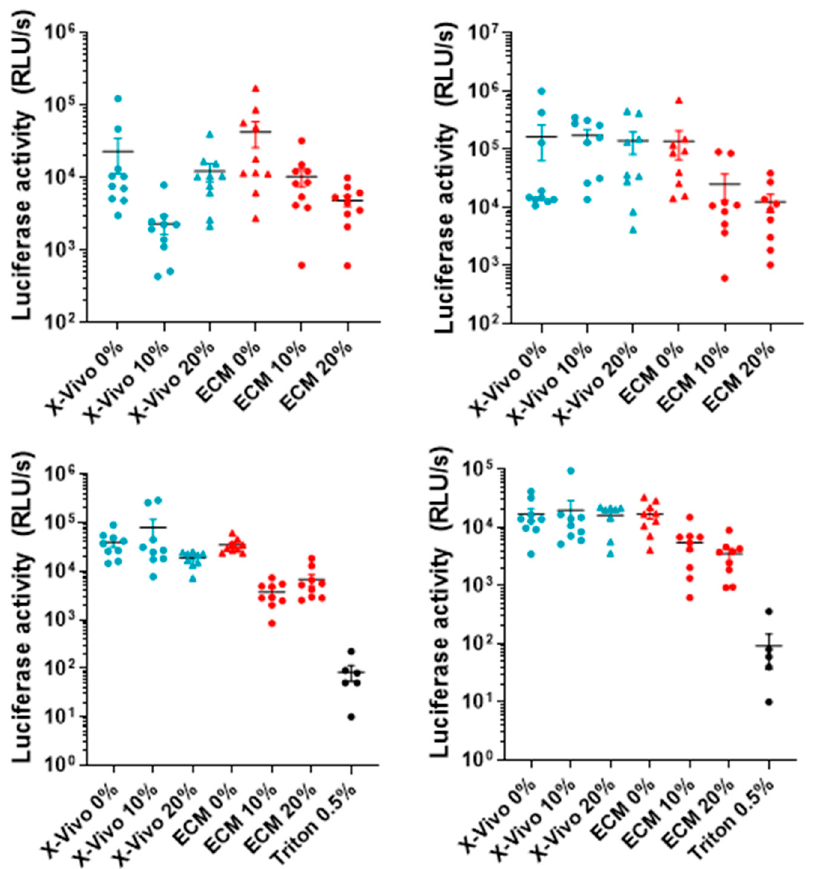
Figure A3. The AG in a serum-free medium strongly reduces seminal plasma-derived cytotoxic effects in primary vaginal tissue. Here, 2 × 2 × 1 mm 3 vaginal tissue blocks derived from four individual donors were incubated with 10% or 20% seminal plasma (or buffer) in the presence of a chemically defined, serum-free medium (X-vivo15) supplemented with 0.05 mM AG or in the presence of ECM growth medium supplemented with 10% FCS. After 3 days, the individual blocks were washed twice with PBS and analyzed using a CellTiter-Glo™ viability assay. Here, 0.5% triton was used as a toxic control. Black lines indicate averages, and RLU/s is defined as relative light units per second.